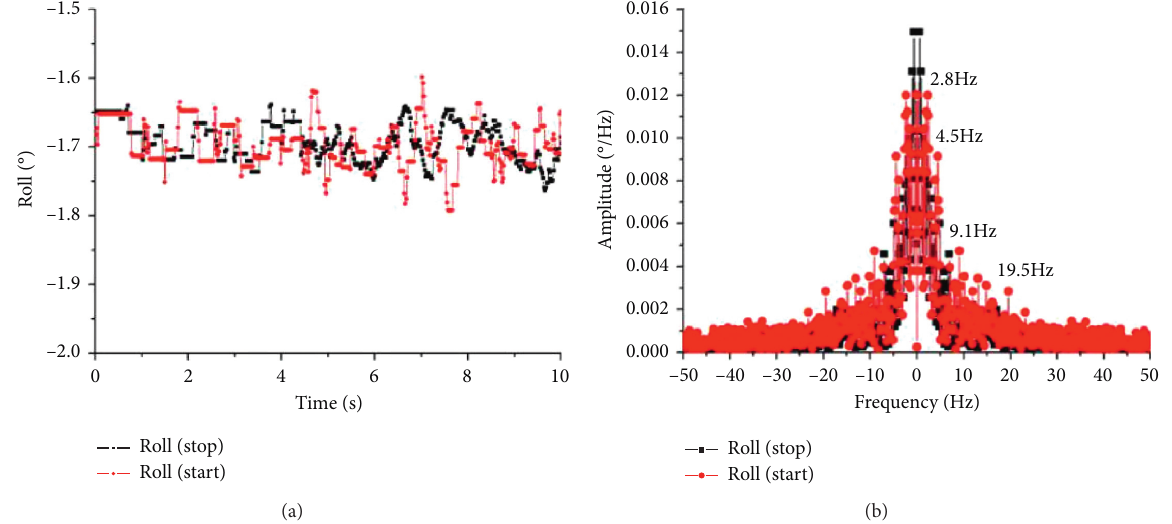
Figure 7: (a) Rolling angle change when the engine starts and stops. (b) Fluke spectrum change when the engine starts and